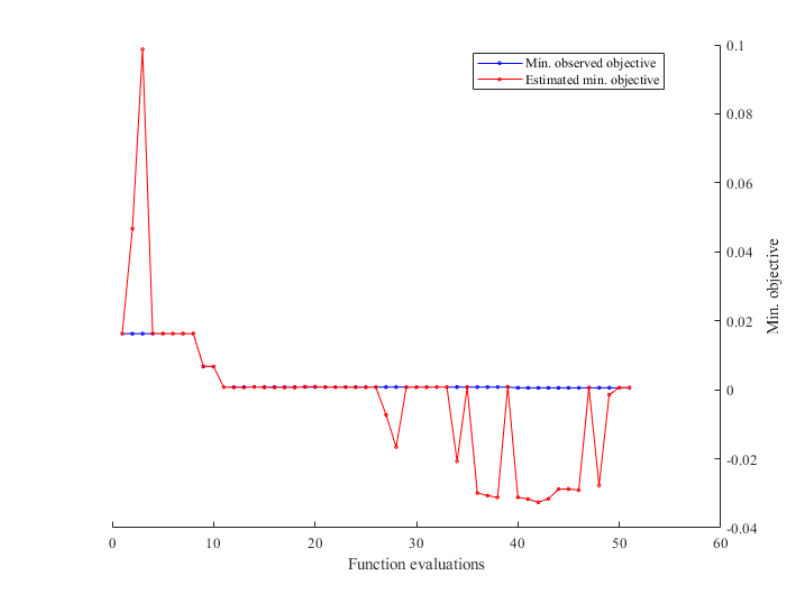
Figure 5. Min. objective through function evaluations.